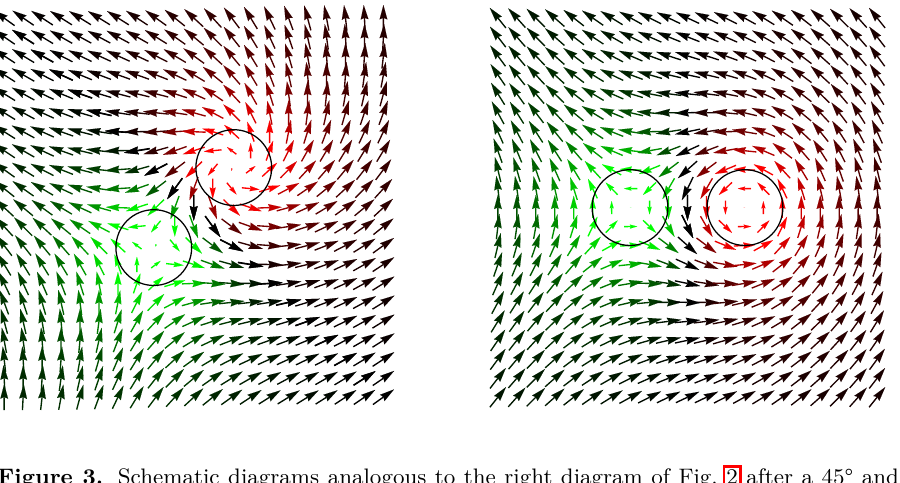
Figure 3. Schematic diagrams analogous to the right diagram of Fig. 2 after a 45° and a 90°